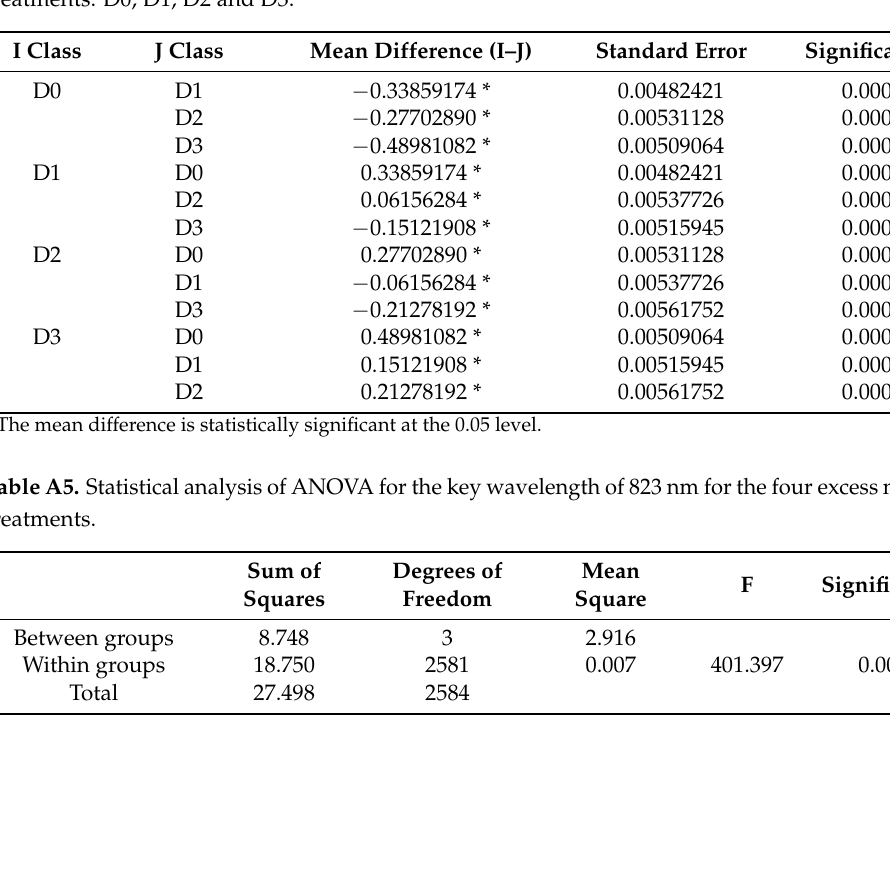
Table A4. Statistical Tukey’s HSD test for the key wavelength of 783 nm for the four excess nitrogen treatments: D0, D1, D2 and D3.